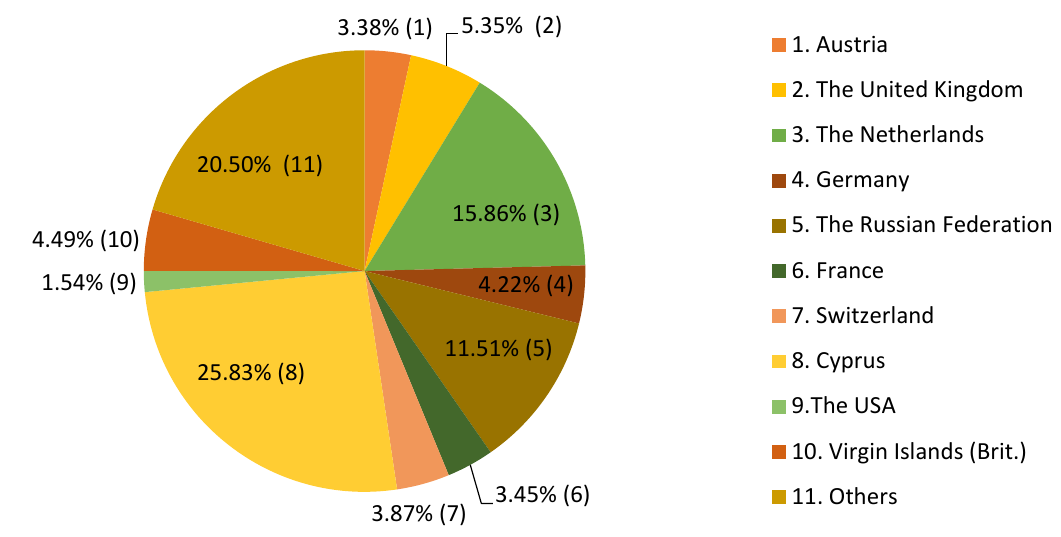
Figure 1. Direct investments from countries into Ukrainian economy in 2016